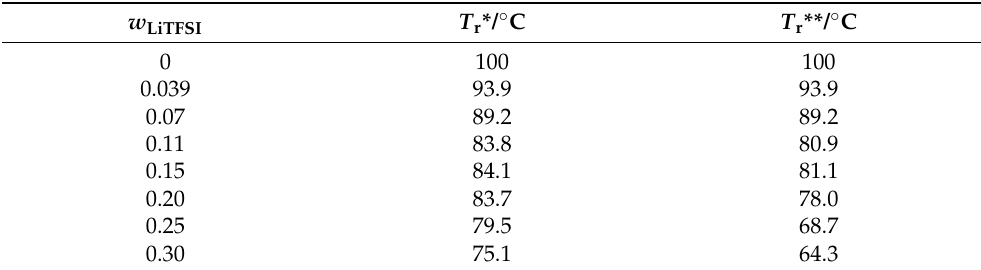
Table 1. Reference temperatures, T r * and T r **, respectively determined from the WLF analysis and superposition of G * spectra for PC 4 -TFSI/LiTFSI mixtures with various w LiTFSI